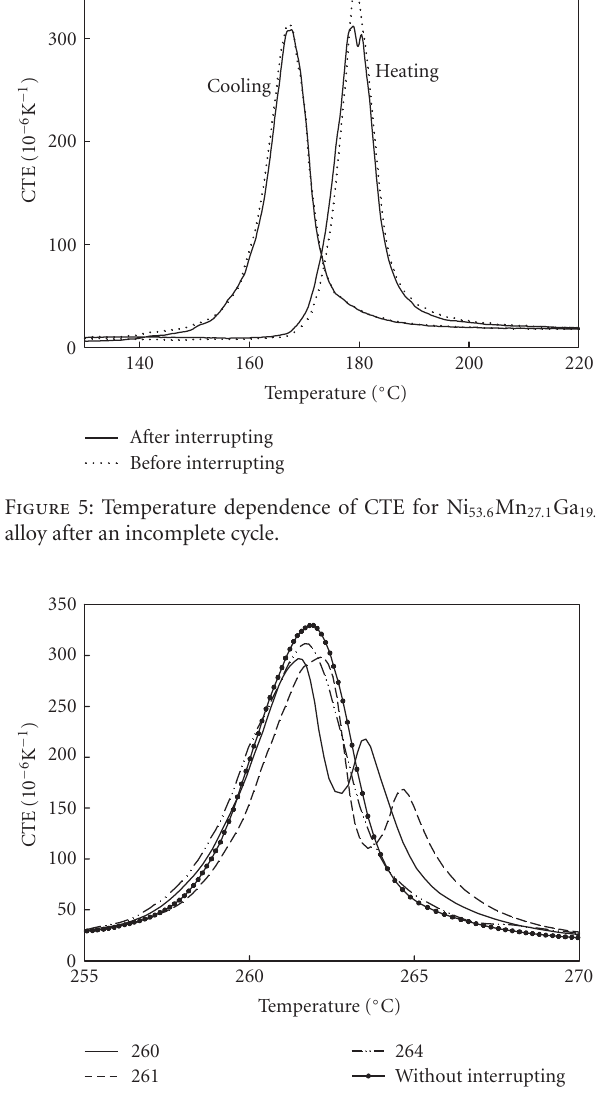
Figure 6: Temperature dependence of CTE for Ni 54 . 2 Mn 29 . 4 Ga 16 . 4 alloy after a single stop at T = 260 ◦ C, 261 ◦ C, and 264 ◦